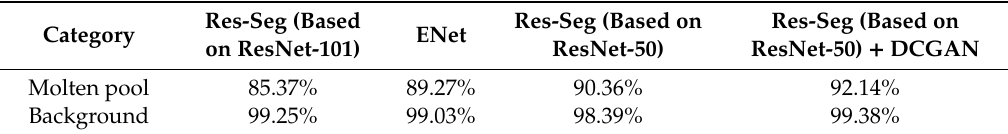
Table 3. Robustness test set segmentation accuracy.